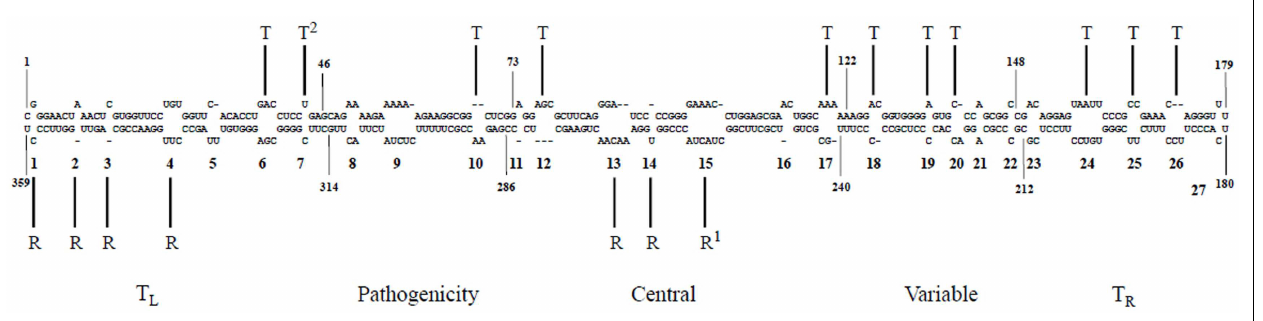
FIGURE 5 |A genomic map of PSTVd loop motifs that are essential/critical for replication and systemic trafficking. Superscripts 1 and 2 refer to data from Zhong et al. (2006) and Zhong et al. (2007), respectively. R, replication;T, trafficking. Reproduced with permission from Zhong et al.